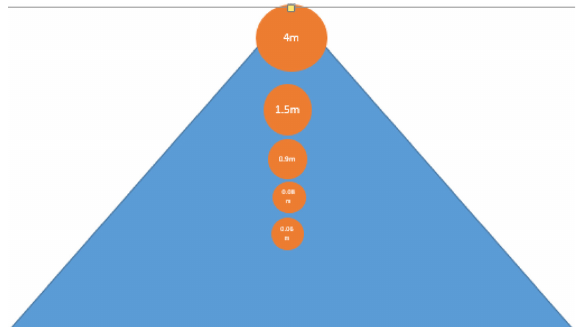
Fig. 12. Diagram representing the real hierarchical distribution of cities and urban areas with their ranks in the Makkah Province. Source: Ledraa 2016.